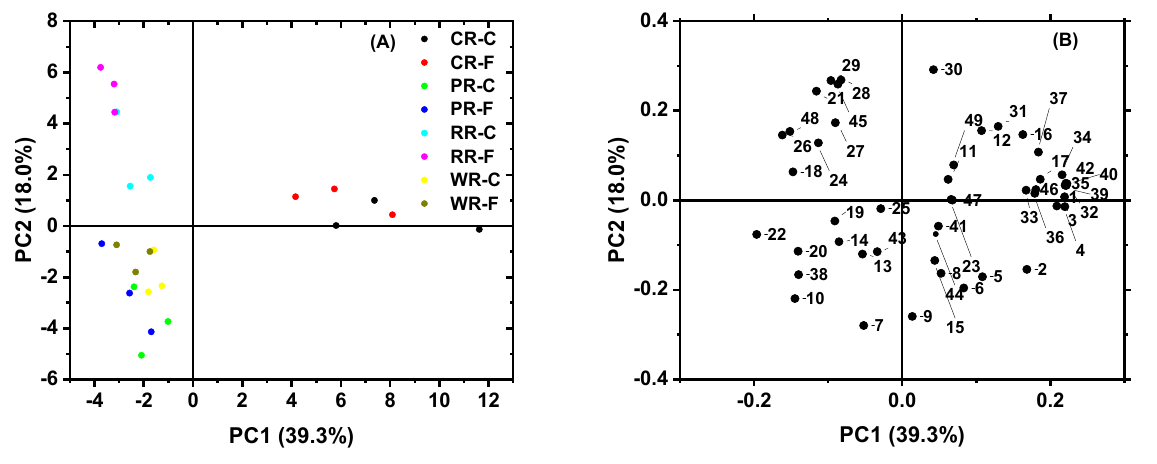
Figure 4. Principal component analysis of rice samples based on volatiles. ( A ): score plot; ( B ): loading plot. RR: raw rice; WR: washed rice; PR: presoaked rice; CR: cooked rice; C: Chunjiangnuo; F: Fuxiangnuo. Compounds 1 – 49 , see Table S1.